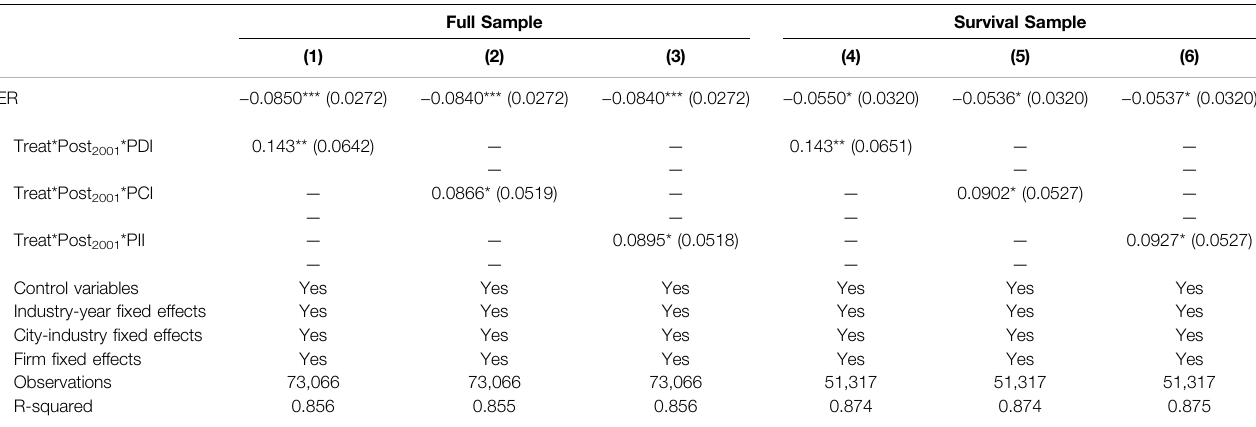
TABLE 2 | Results of cost